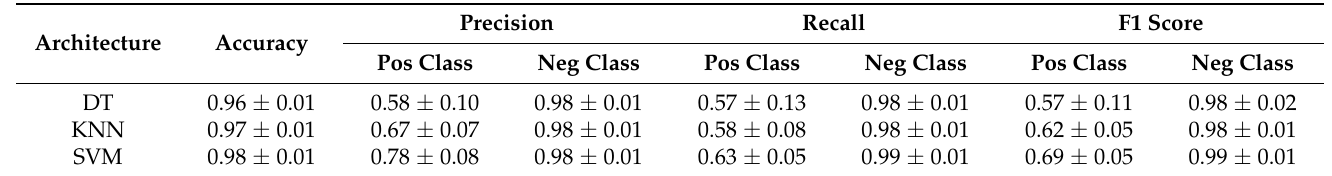
Table 2. The experimental outcome of workflow II using all employed techniques. Pos and Neg represent the positive and the negative classes, respectively.